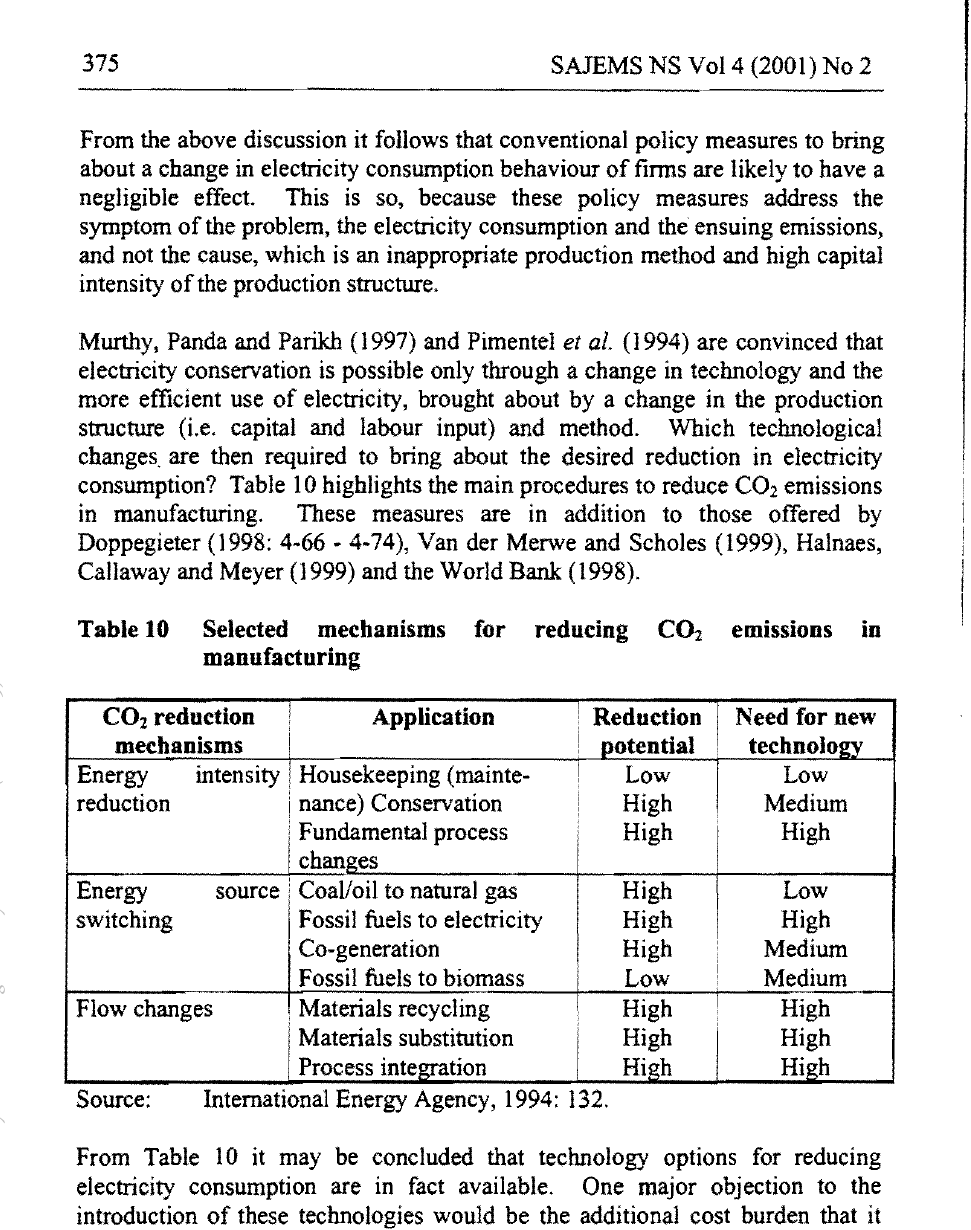
Selected mechanisms for reducing CO